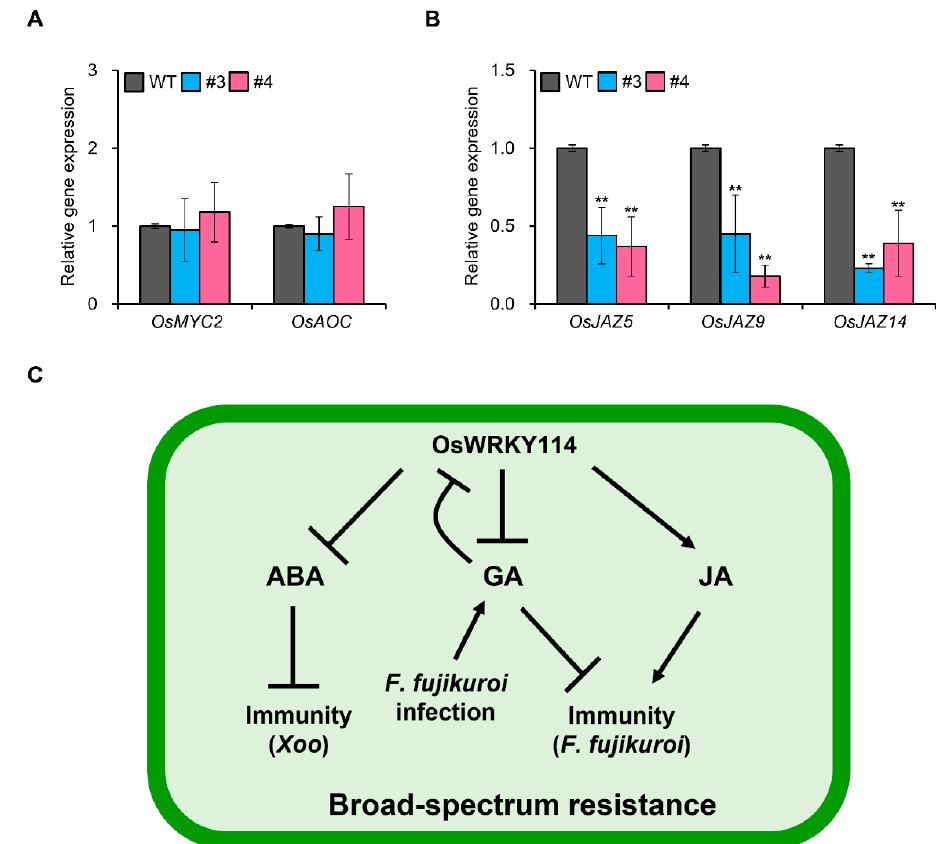
Figure 3. OsWRKY114 decreases OsJAZ gene expression. ( A , B ) Relative expression levels of JA- related genes in OsWRKY114 OX . Total RNA was extracted from 6-day-old OsWRKY114 OX and WT seedlings. The transcript levels of genes encoding positive regulators ( A ) and negative regulators ( B ) of JA signaling were analyzed via RT-qPCR. OsActin was used as an internal control to quantify relative gene expression. Values are expressed as means ± SD. Asterisks indicate values significantly different from those of the WT control (** p < 0.01). All experiments were repeated at least three times, with similar results. Representative graphs are shown. ( C ) A working model of OsWRKY114- induced broad-spectrum resistance via the regulation of phytohormone signaling. OsWRKY114- mediated inhibition of ABA signaling increases resistance to Xanthomonas oryzae pv. oryzae , while downregulating GA and upregulating JA signaling via OsWRKY114 enhances resistance to Fusarium fujikuroi .